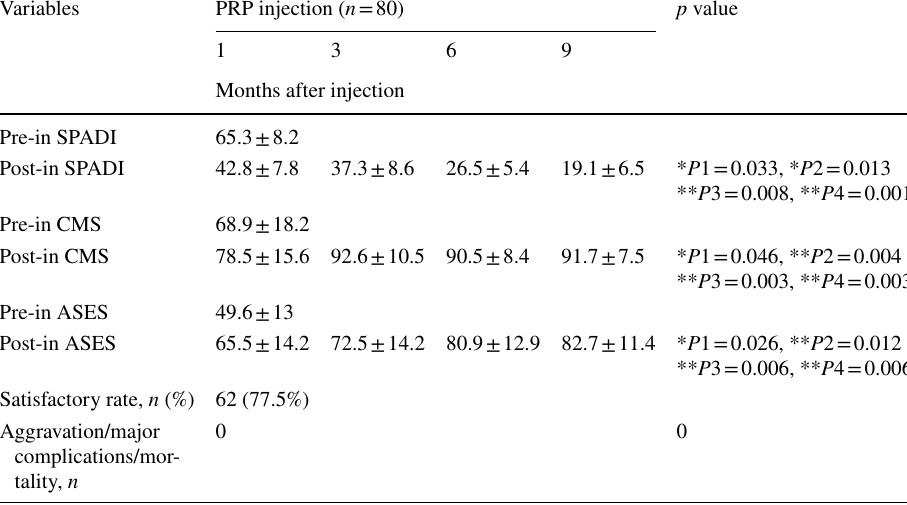
Table 2 Clinical evaluation